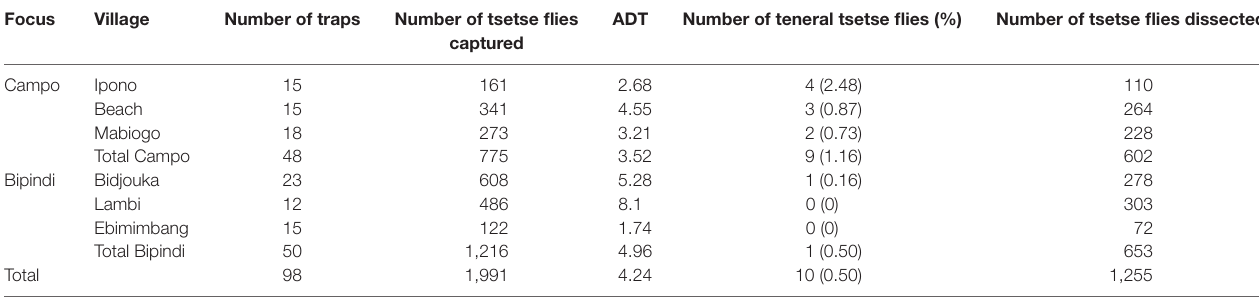
ADT, apparent density per trap per